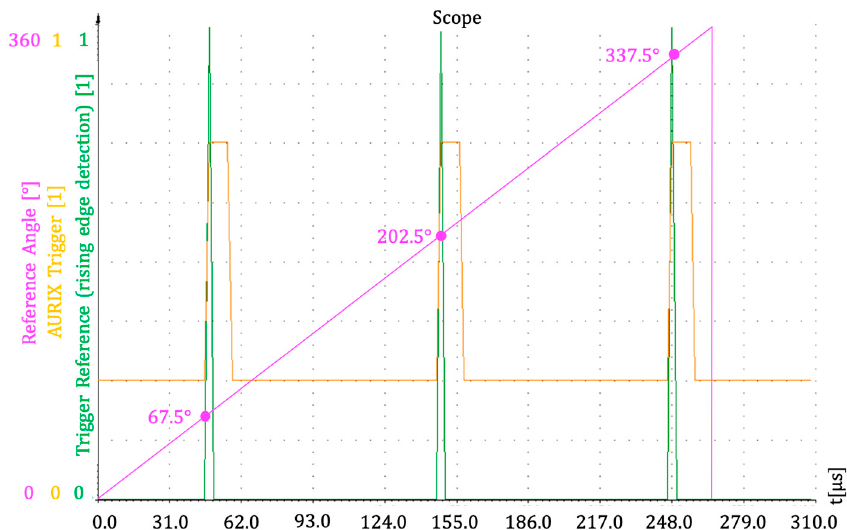
Figure 11. Exemplary measurement scenario of the reference sensor at a certain, constant angular velocity showing the μ C trigger signal (AURIX Trigger) in orange color, the internal detected rising edge of the trigger signal in green color and the reference angle including the theoretical possible triggered reference position readout in magenta.